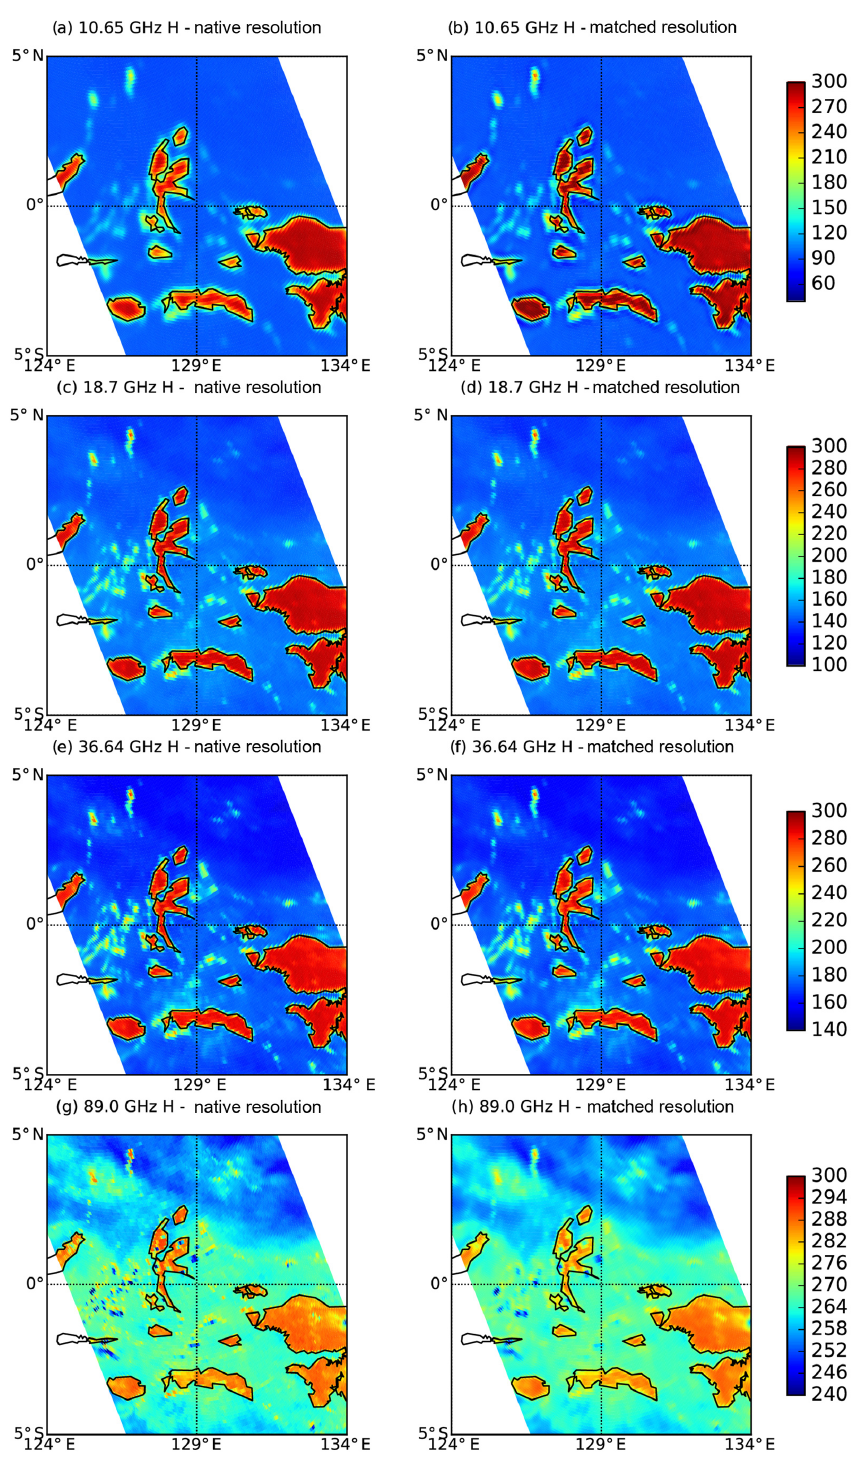
Figure 7. A sample of GMI imagery before (left column) and after (right column) the resolution matching procedure. For 18.70GHz, which defines the target EFOV, no adjustment is made. Results are not shown for 23.8GHz, as the effects of the resolution matching are almost imperceptible at this